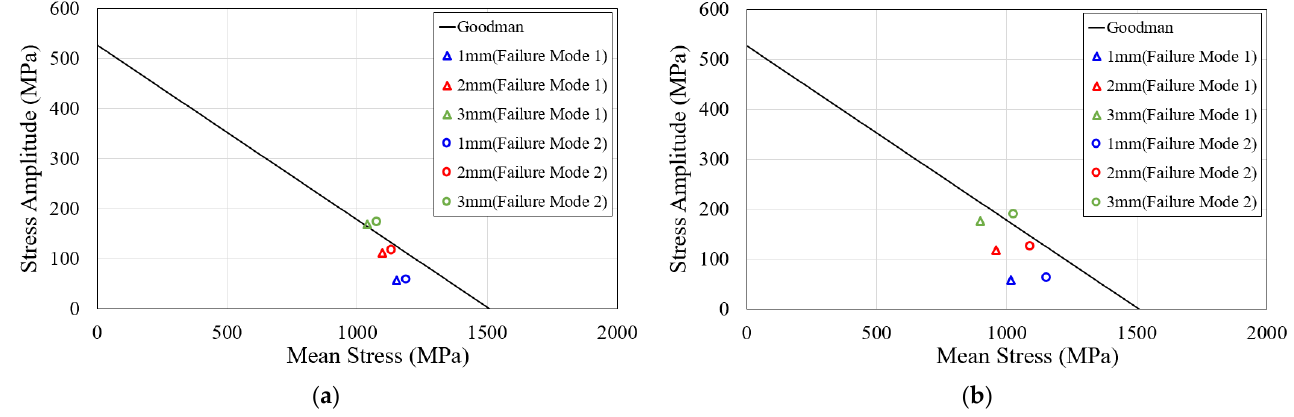
Figure 14. Fatigue performance evaluation of the rail clips: ( a ) step 1; ( b ) steps 1 – 2. Table 3. Stress conditions for fatigue performance evaluation.